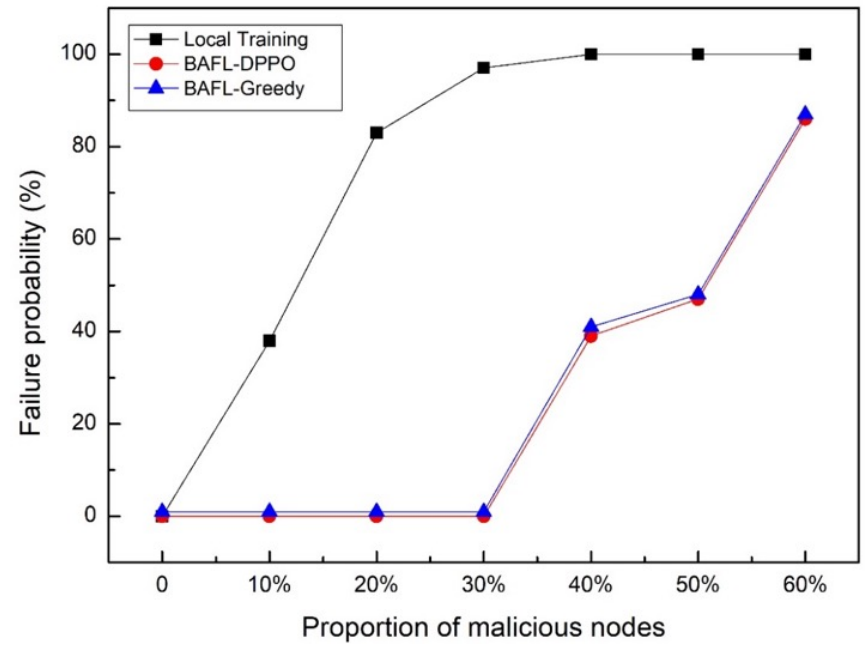
Figure 10. Defending against malicious attack.